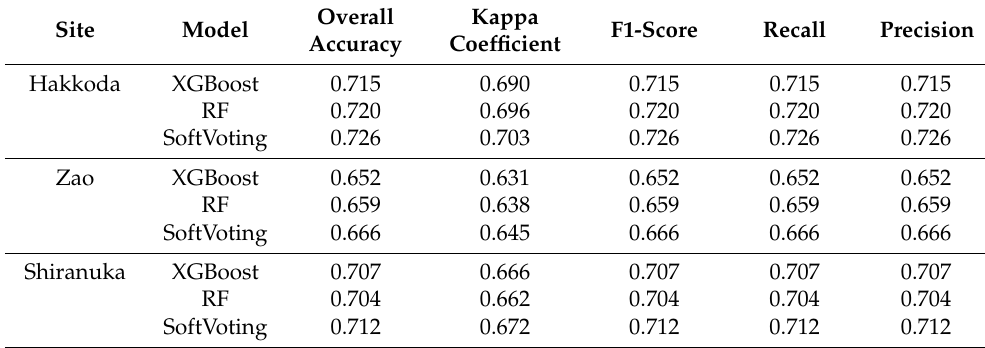
Table 4. Performance of the ultra-resolution suite using single-date autumn images.